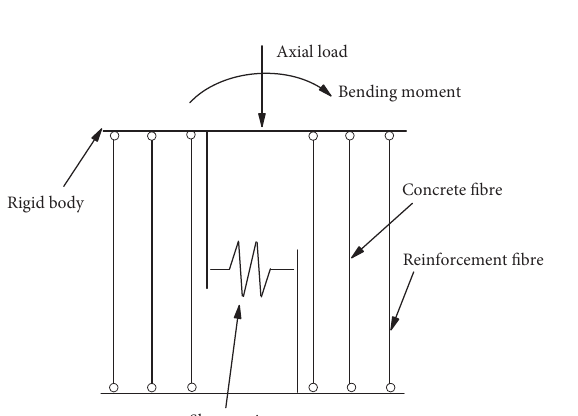
Figure 2: Fibre model of the shear wall.